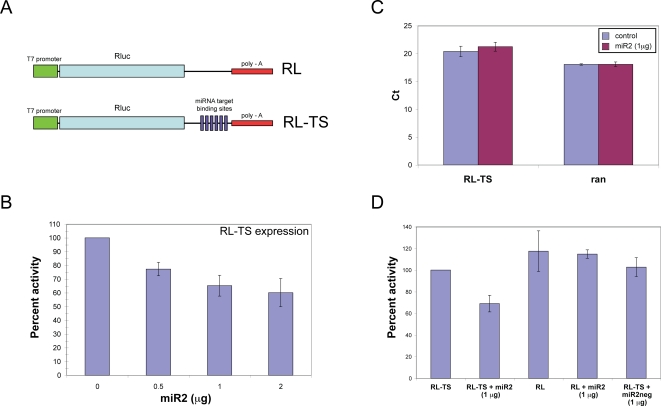
miR2-mediated translational repression of mRNA with putative target site at the 3′-UTR.(A) Diagram of the reporter constructs RL and RL-TS. (B) Percent luciferase activity of Giardia trophozoites transfected with RL-TS plus different concentrations of exogenous miR2. These results represent the average number and standard deviation of at least two replicates. (C) Real time quantitative RT-PCR comparison of RL-TS mRNA concentrations in the presence and absence of exogenously introduced miR2. Ran mRNA was monitored as a control. The data represent the average number and standard deviation from three independent transfection experiments. (D) Percent luciferase activity in RL-TS and RL transfected cells. The introduction of miR2 (1.0 µg) represses RL-TS activity by 35%. The absence of target sites (TS) in RL results in a small increase of expression by ∼15% that is not repressed by co-transfection with miR2. This suggests that the target sites are required for repression of luciferase activity by both endogenous and exogenous miR2. The use of a mutant miR2, miR2neg, does not affect the luciferase activity, indicating a specificity between miR2 and its target sites. These data represent the average number and standard deviation of four independent transfection experiments.